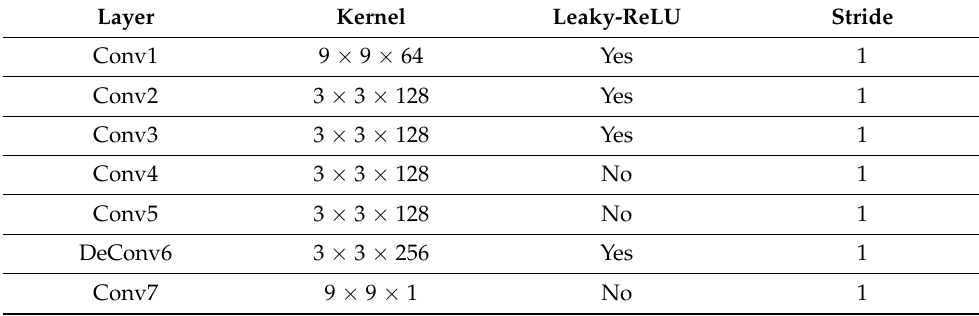
Table 1. The parameter settings of Convolutional Neural Network.